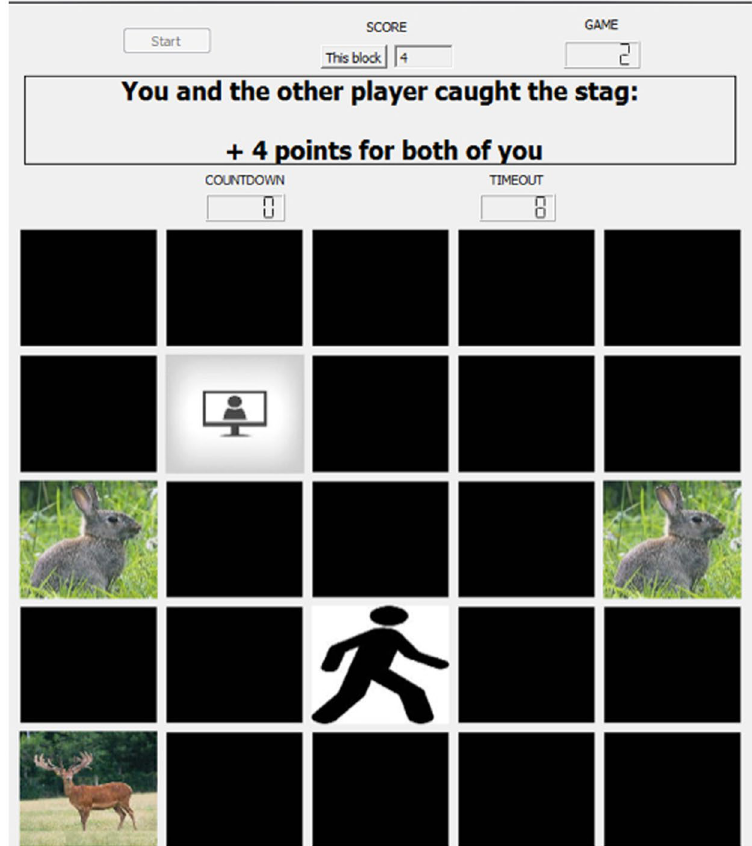
Figure 1. Stag Hunt game environment. Subjects moved their avatar (stick figure) across the 5 × 5 game board using the arrow keys in order to catch a low payoff hare individually, or attempt to catch a high payoff stag with the computer agent (silhouette in computer screen). To catch a stag, both the subject and the agent must move their avatars into a square directly adjacent to the stag square, and the subject must press the Space bar. To catch a hare, the subject must move their avatar on top of a hare square and press the Space bar. When a prey was successfully caught by one of the subjects, the game ended and points were awarded based on